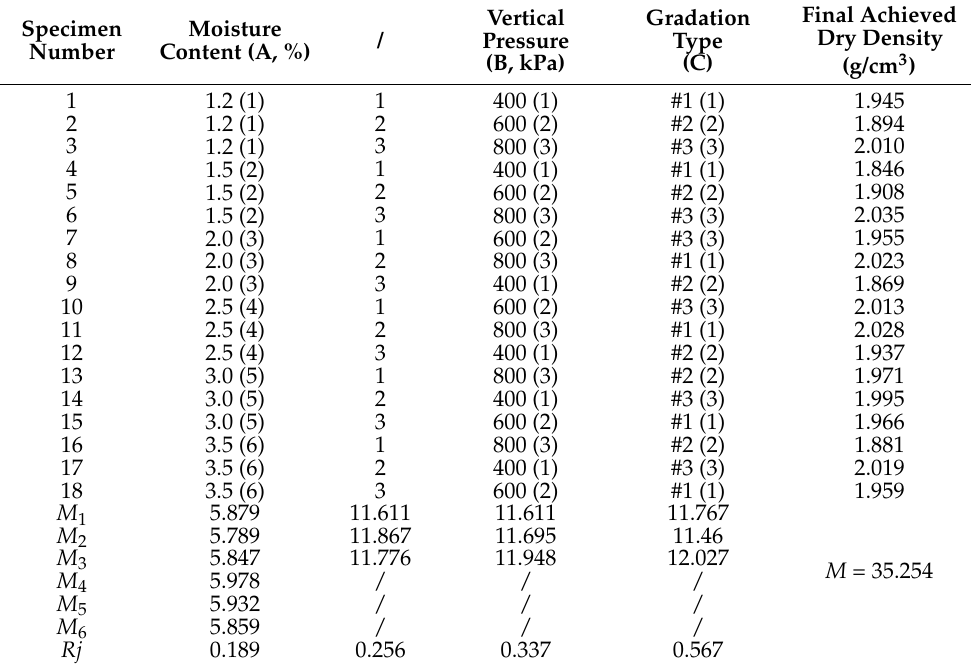
Table 2. The final achieved dry density results from gyratory compaction tests with orthogonal array testing